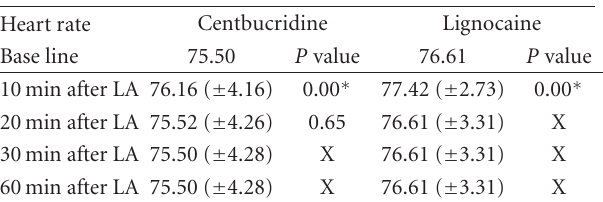
Table 4: Comparison of mean heart rate at various time intervals using Centbucridine and